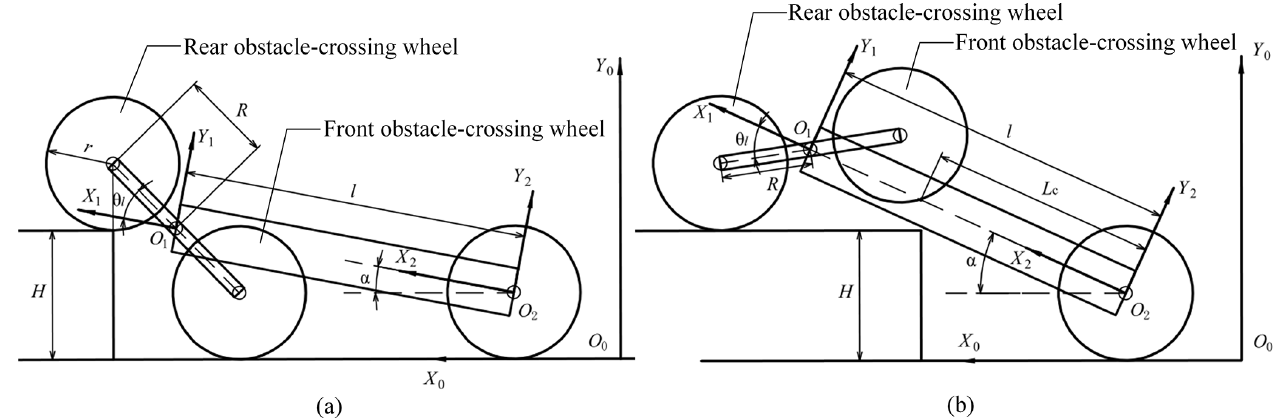
Figure 11. The adaptive climbing rocker arm continues to turn and lift the front obstacle-crossing wheel.